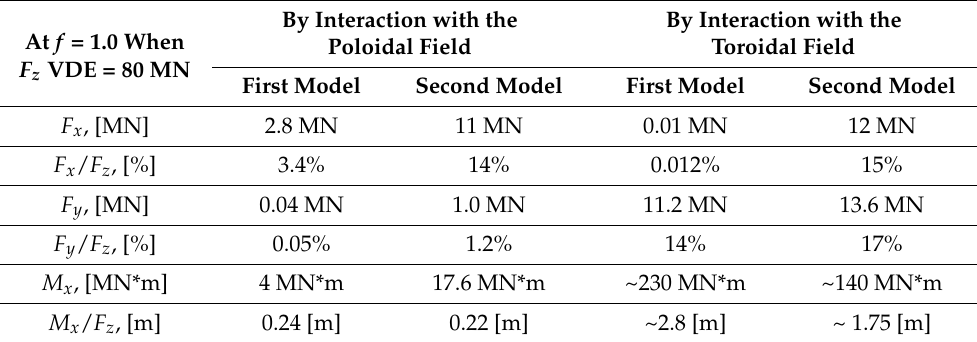
Table 2. All doubled peaks lateral forces and lateral torque at VV (with blanket and divertor) due to only the anti-symmetric halo current component scaled to the higher fraction of the anti-symmetric halo current density f = 1.0, and their percentage of peak vertical force either at VV or at the Magnets ( ≈ 80 MN) calculated for the corresponding symmetric VDE. By Interaction with the By Interaction with the At f = 1.0 When Poloidal Field Toroidal Field F z VDE = 80 MN First Model Second Model First